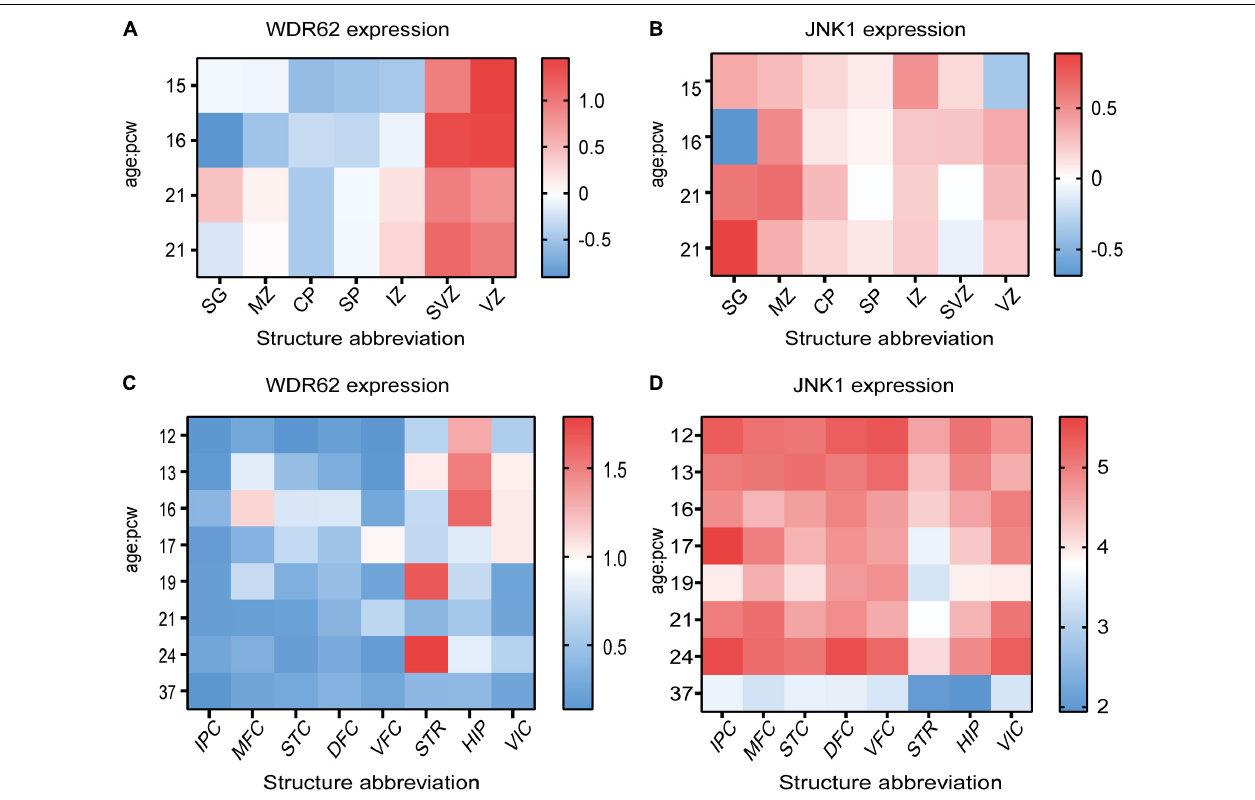
FIGURE 1 | WDR62 and JNK1 expression during human brain development. (A,B) Heatmap showing the expression levels of WDR62/JNK1 in different cortical layers of cortex at post-conception weeks (PCW) 15, 16, and 21. (C,D) The transcriptional expression of WDR62/JNK1 in different regions of human brains at PCW 12–37. Two different samples (male and female) are depicted in the expression of WDR62 and JNK1 in different layers of cortex. Red depicts high expression, and blue depicts low expression. CP, cortical plate; DFC, dorsolateral prefrontal cortex; HIP, hippocampus; IPC, inferior parietal cortex; IZ, intermediate zone; MFC, medial prefrontal cortex; MZ, marginal zone; SG, subpial granular zone; SP, subplate zone; STC, caudal superior temporal cortex; STR, striatum; SVZ, subventricular zone; VFC, ventrolateral prefrontal cortex; VIC, primary visual cortex; VZ, ventricular